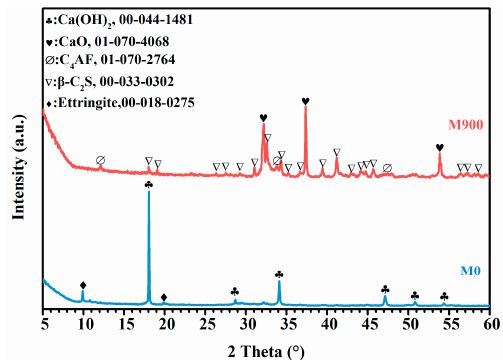
Figure 3. XRD patterns of hydrated cement M0 and M900.